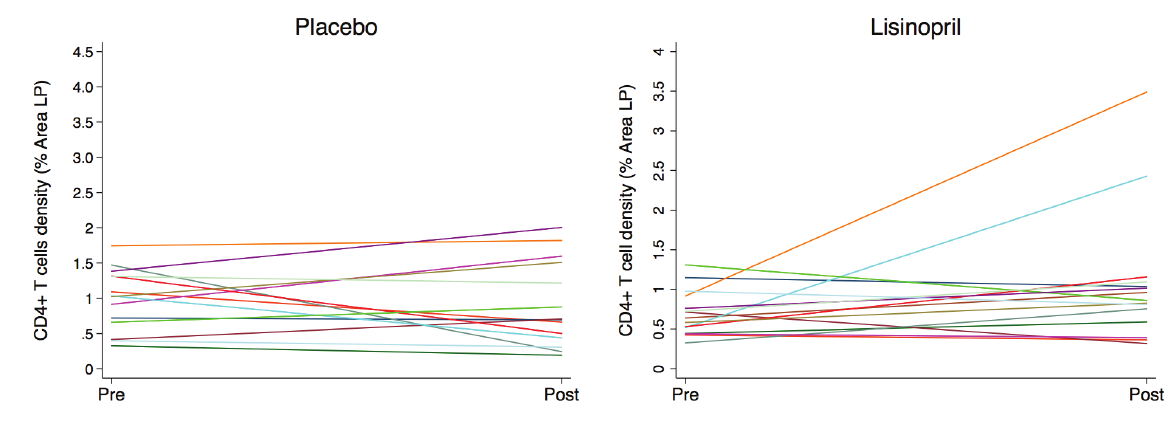
Figure 5. + Change in density of CD4 T cells as a percentage of area in the lamina propia from base- line to week 22 in the placebo and lisinopril treatment